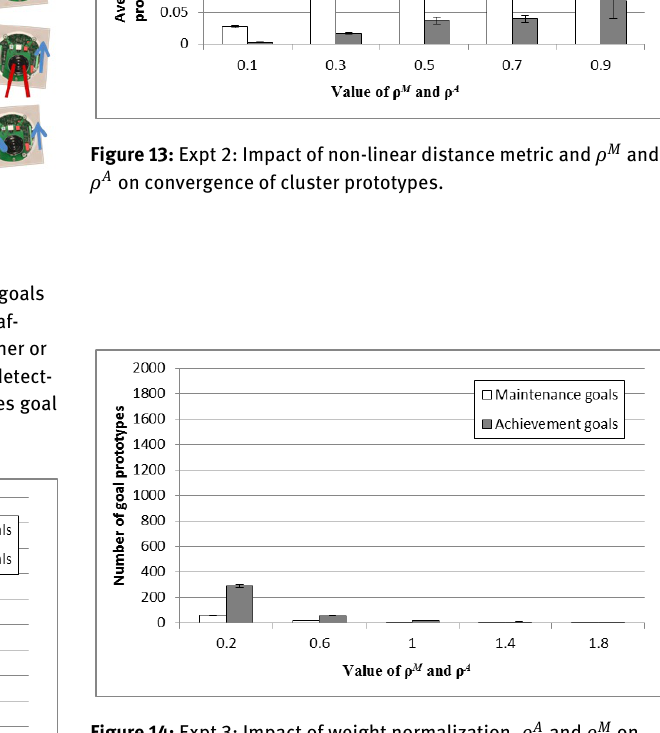
Figure 14: Expt 3: Impact of weight normalization, ρ A and ρ M on number of of achievement (grey) and maintenance goals (white).